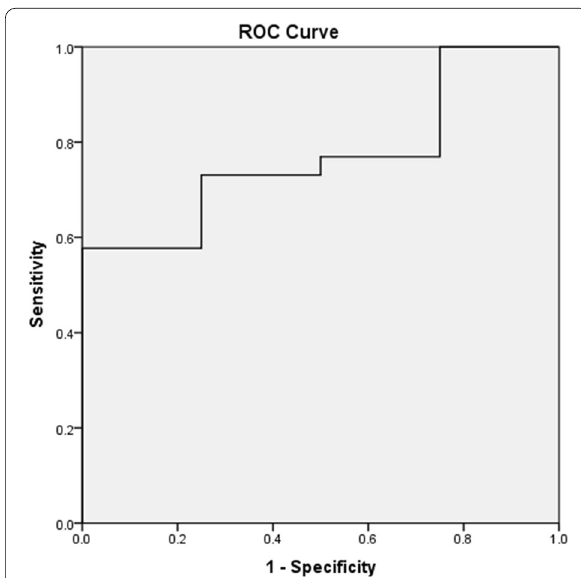
Fig. 3 ROC curve for TNF‑α to detect cognitive impairment in patients with PD using ACE III. We observed that at cut‑off point value > 110.7, the sensitivity and specificity of TNF‑α were 73.1, 75%, respectively (AUC 0.76, p value 0.08). TNF-α tumor necrosis = = factor‑α, PD Parkinson’s disease, ACE-III Addenbrooke’s Cognitive